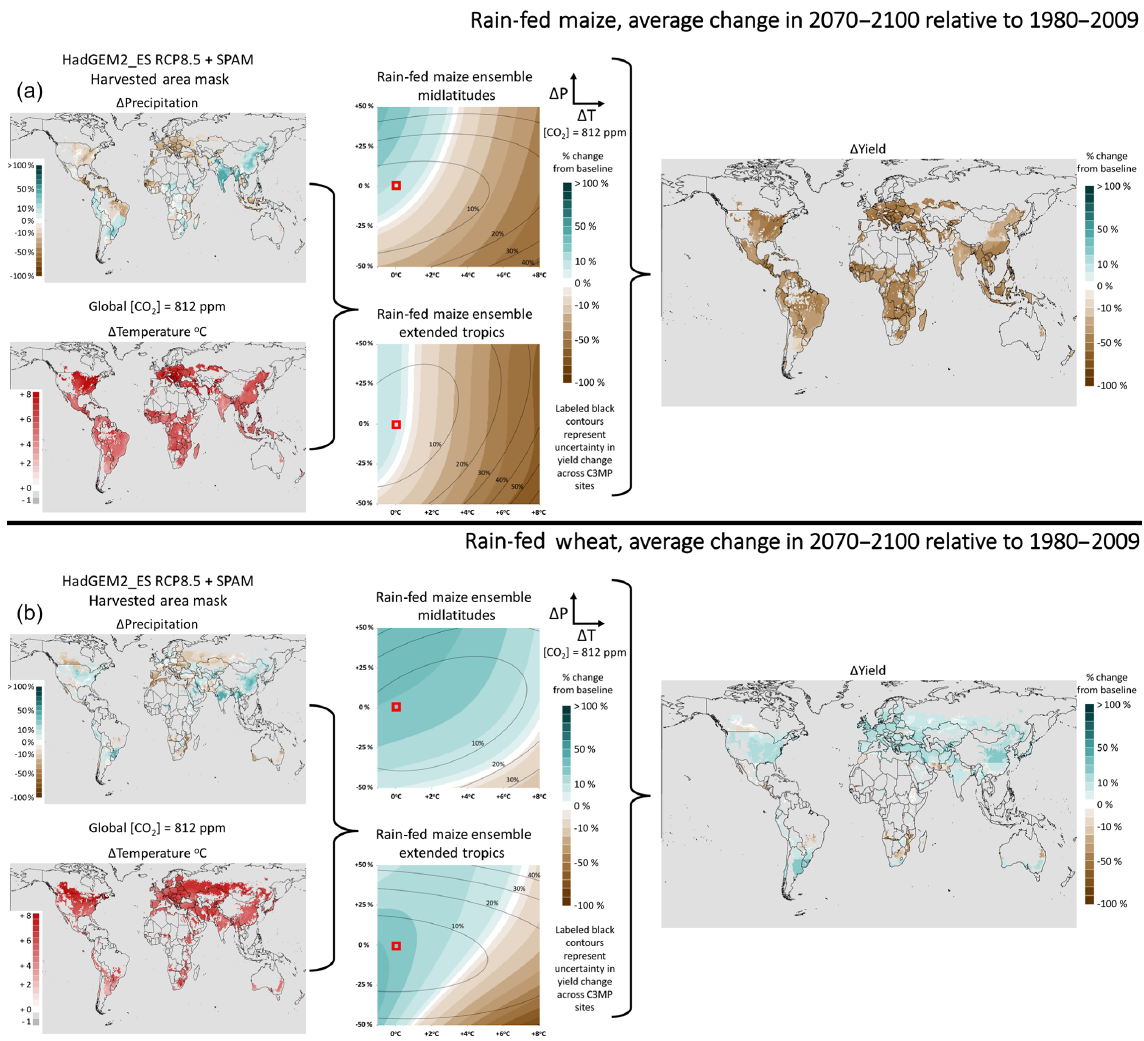
Figure 10. Tracing the path from gridded local growing season temperature and precipitation changes and global CO 2 = 812ppm concentra- tion under HadGEM2-ES RCP8.5 for 2071–2100 compared to 1980–2009, through the relevant yield response functions (represented here as impact response surfaces) to generate mean yield change maps for rain-fed maize (a) and rain-fed wheat (b) . The open red square is placed at no change in temperature and precipitation for each impact response surface. For plotting clarity, we use a harvested area mask of grid cell harvested area greater than 10ha in the SPAM 2005 data set (You et al.,